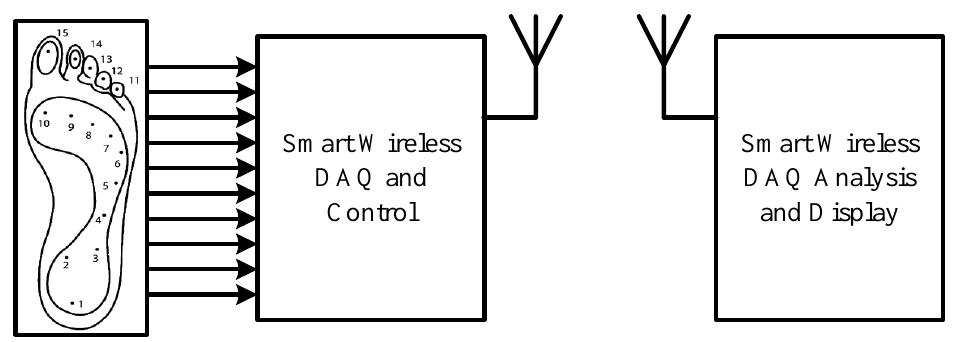
Figure 36. Block diagram of the proposed